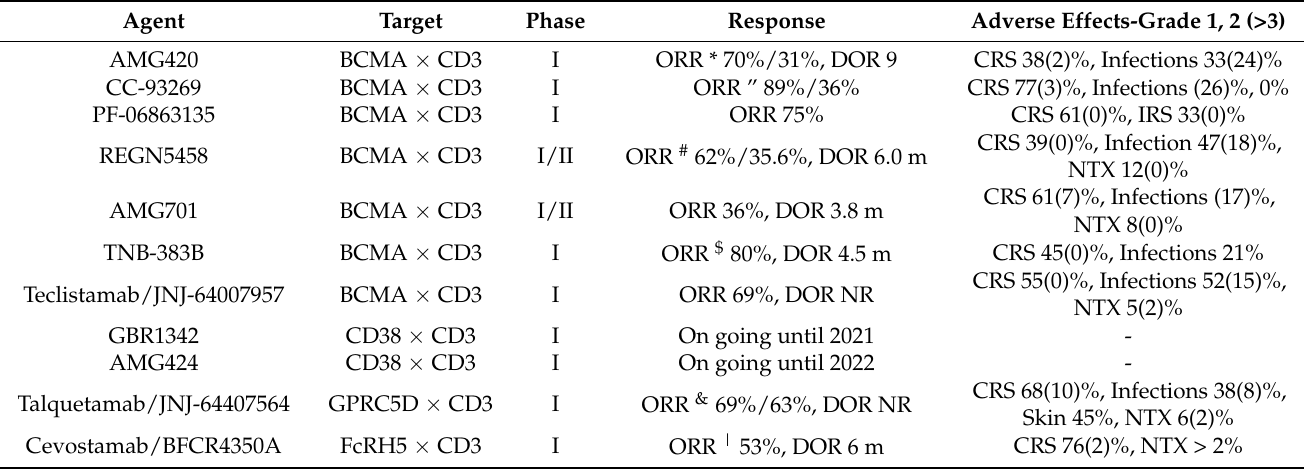
Table 2. Bispecific antibody (BsAb) in